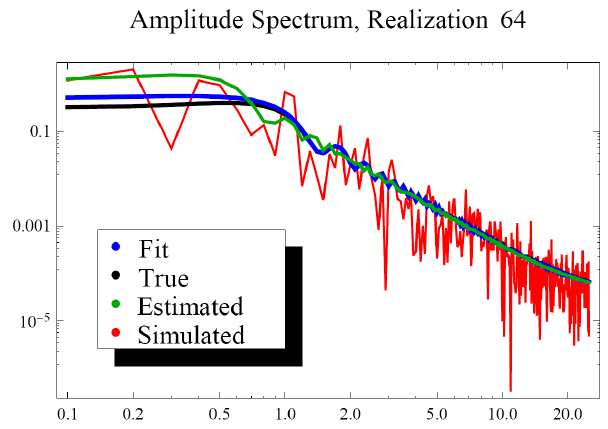
Fig. 13. Amplitude frequency spectrum (in Hz) for realization 64, showing fit ( η = 20 200, L = 5km, and C 2 η 1η = 3 . 84 × 10 − 9 ), compared to estimated ( η = 17 210km, L = 5km, and C 2 η 1η = 8 . 4 × 10 − 9 ).